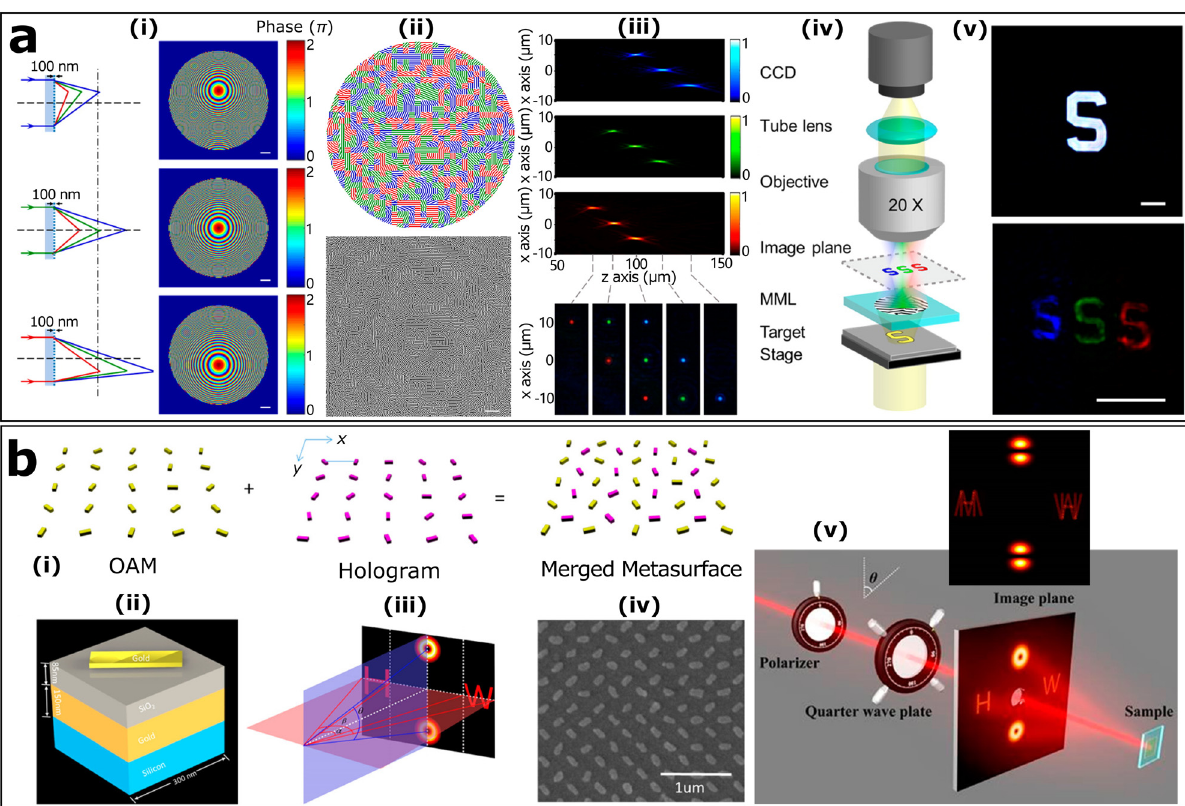
Figure 1: The segmented and interleaved